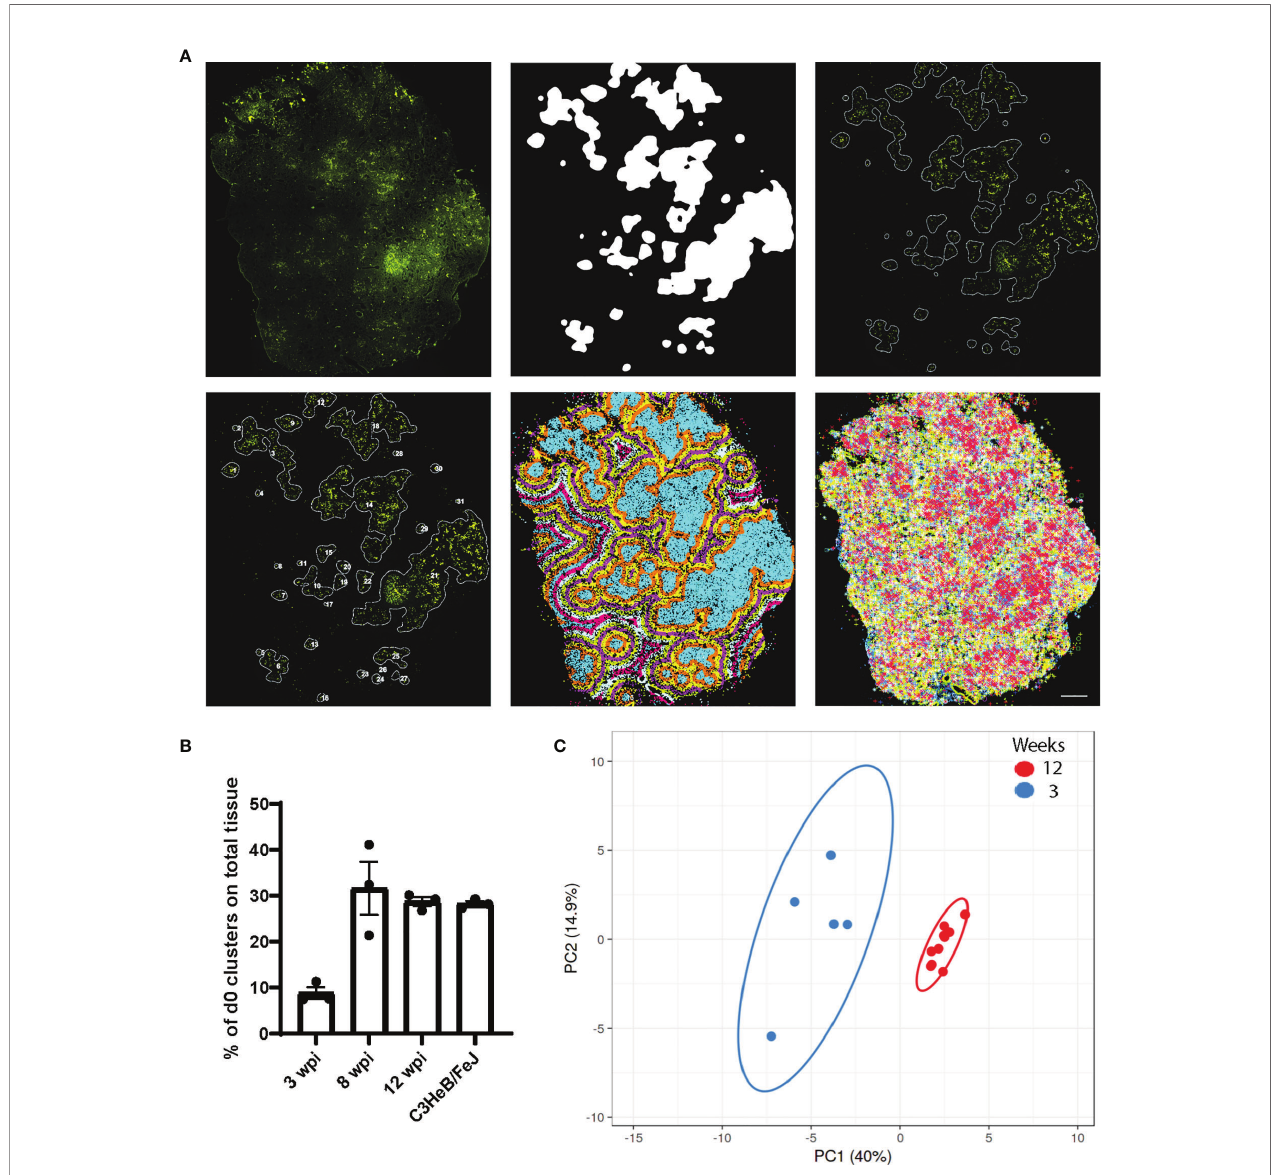
FIGURE 4 | Bacteria clusters and their immune pattern in C57BL/6 mice. (A) Exemplary input and output of bacteria cluster pipeline for one C57BL/6 section at 12 wpi shows the AR image (top left) and cluster identi fi cation on the 20% subtracted image (top middle, top right), based on AR staining signal intensity. Lower panel displays cluster labeling for individual cluster analysis (bottom left), the applied 100 m m gradient around identi fi ed clusters (bottom middle), and plotted immune transcripts (bottom right). Scale bar: 1,000 m m. (B) Percentage of tissue area occupied by bacteria cluster (d0) for C57BL/6 lung sections at 3, 8, and 12 wpi and for C3HeB/FeJ lung sections at 10 wpi is displayed. Mean frequencies ± SEM for three sections per condition are shown. (C) Principal component analysis displays the density ratio of immune transcripts in bacteria clusters identi fi ed in a representative section at 3 (blue, n = 5) and 12 (red, n = 10) wpi in C57BL/6 mice. The ellipse around the clusters indicates the area in which 95% of the samples would be located based on gaussian